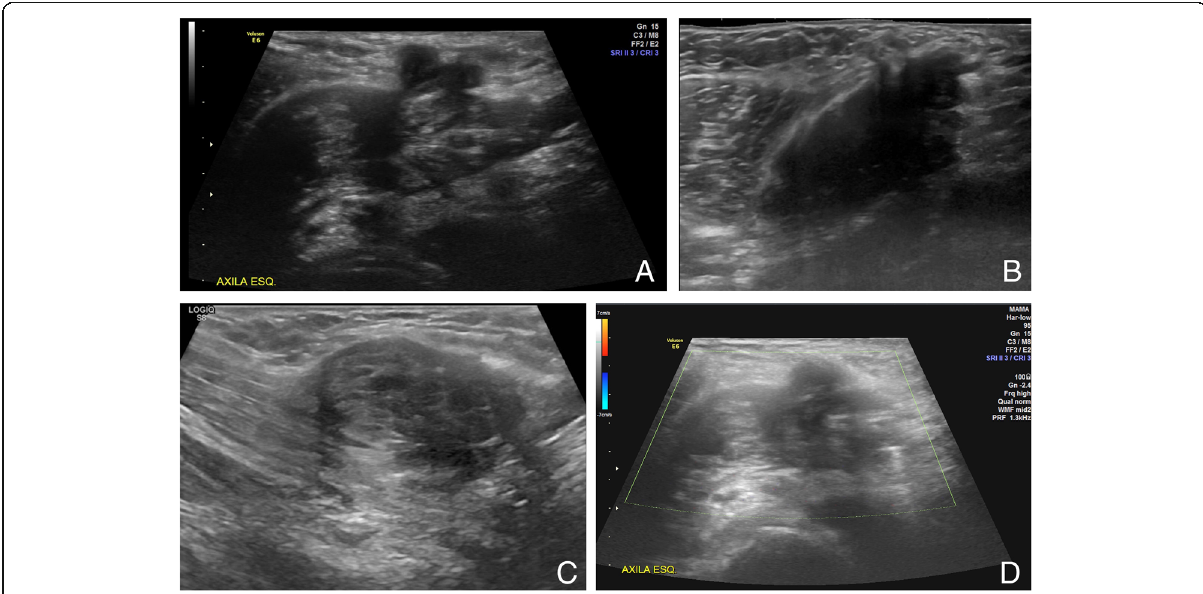
Fig. 1 US of the left axillary region. A Longitudinal image of the solid, heterogeneous, elongated, irregular lesion, with alternating echogenicities arranged in layers (pink arrow), forming the tail sign (green arrow) along the longest axis. B Extended view of the aforementioned lesion, showing digitiform extensions that extend to adjacent adipose planes (blue arrows). C Transverse image of the tumor, showing alternating echogenicity layers (pink arrow) as well as signs of invasion of the coracobrachialis muscle (white arrow). D There was no vascularity detectable in the color Doppler